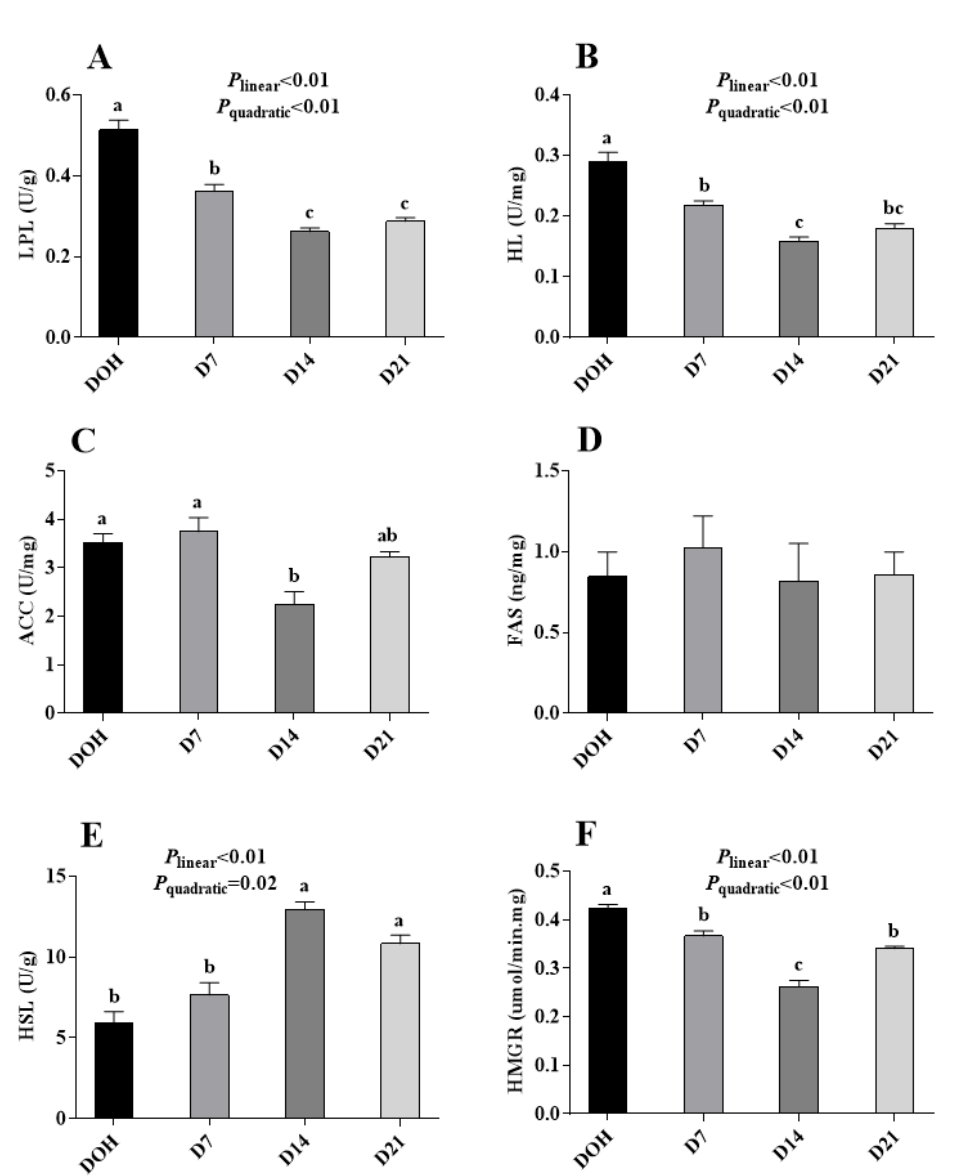
Figure 3. The age-related changes in activities of hepatic lipid metabolism-related enzymes of domestic pigeon squabs. ( A ) lipoprotein lipase (LPL) activity, ( B ) hepaticlipase (HL) activity, ( C ) acetyl CoA carboxylase (ACC) activity, ( D ) fatty acid synthetase (FAS) activity, ( E ) hormone-sensitive lipase (HSL) activity, ( F ) 3-hydroxy-3-methyl glutaryl coenzyme A reductase (HMGR) activity. DOH = day of hatch; D7 = day 7 post-hatch; D14 = day 14 post-hatch; D21 = day 21 post-hatch. Values are means ± SEM of 10 squabs, n = 10. a–c Means within the same day sharing no common superscripts differ significantly (Tukey test, p < 0.05).